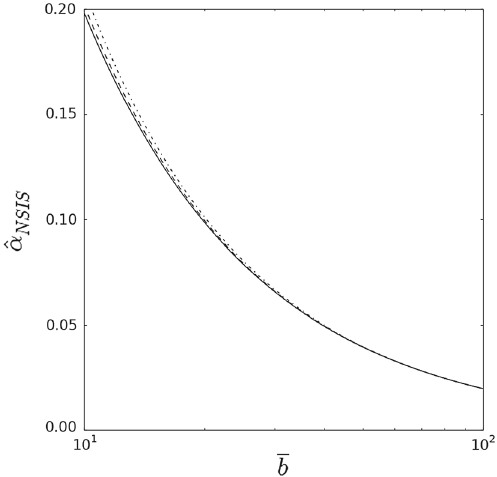
Fig. 8 Plot of ˆ α NSIS vs. b for Λ = 1 (continuous line), Λ = 0 . 25 (dashed line), and Λ = 0 . 1 (dot-dashed line). We used, (cid:22) J r = 0 . 25, r c = 10, sin χ = 1, and ω 2 c /ω 2 = 0 . 5